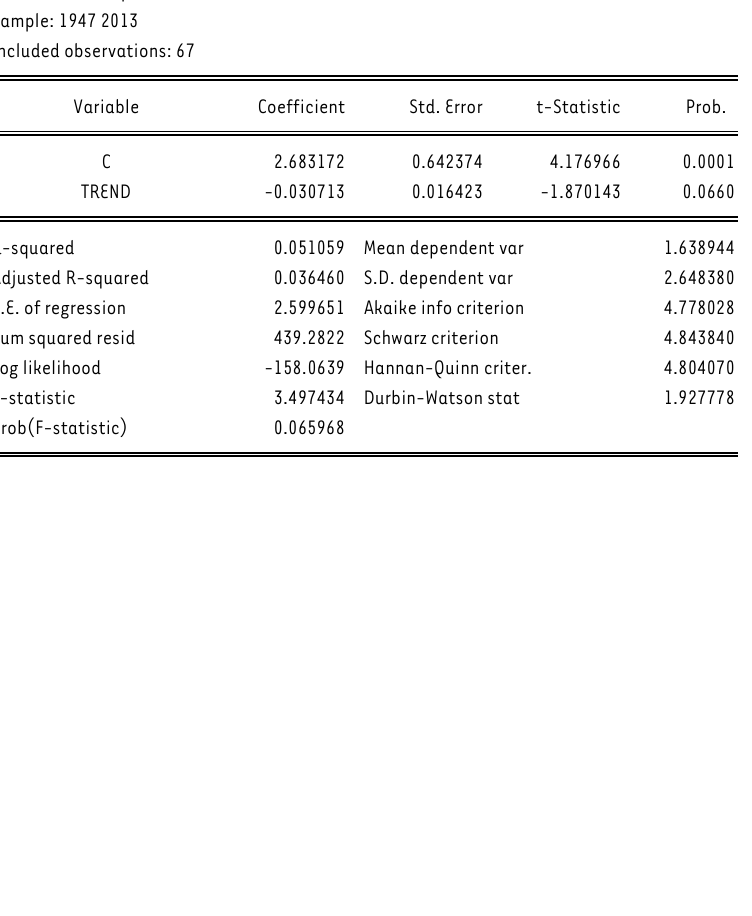
TABLE 6: Labour Growth Trends